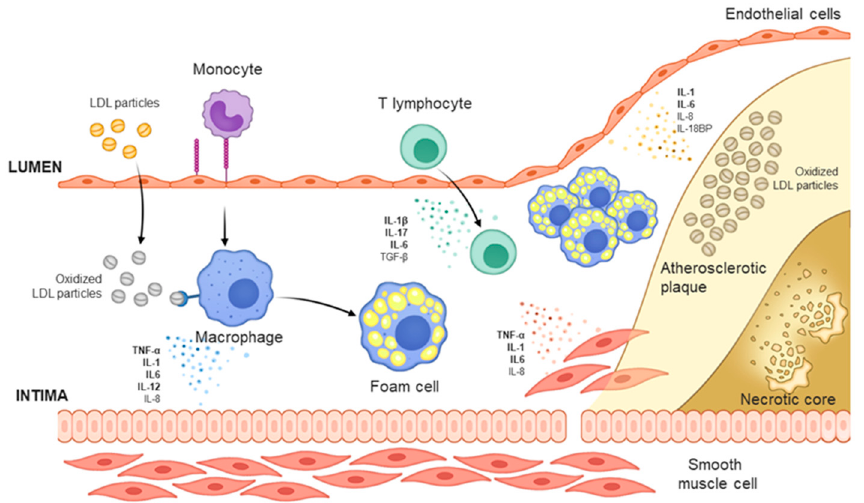
Figure 1. Mechanism of atherosclerosis formation.The development of atherosclerosis begins when low-density lipoprotein (LDL) particles infiltrate the intima layer and accumulate. Within the intima, LDLs form oxidized LDL (oxLDL) through myeloperoxidase and lipoxygenase, bind to the scavenger receptor of macrophage-derived foam cells, and activate the foam cells. Activated foam cells induce inflammation by secreting cytokines through several downstream signals. Concurrently, smooth muscle cells in the media layer migrate to the intima and are transdifferentiated into macrophage-like cells, and under the influence of the cytokines secreted from foam cells, secrete cytokines such as IL-6 to promote inflammation. In the intima, oxLDL increases the expression of adhesion molecules at the endothelial cell surface, leading to the recruitment of monocytes and other immune cells, and promote synergy with the aforementioned phenomena to induce the formation of atherosclerotic plaques.